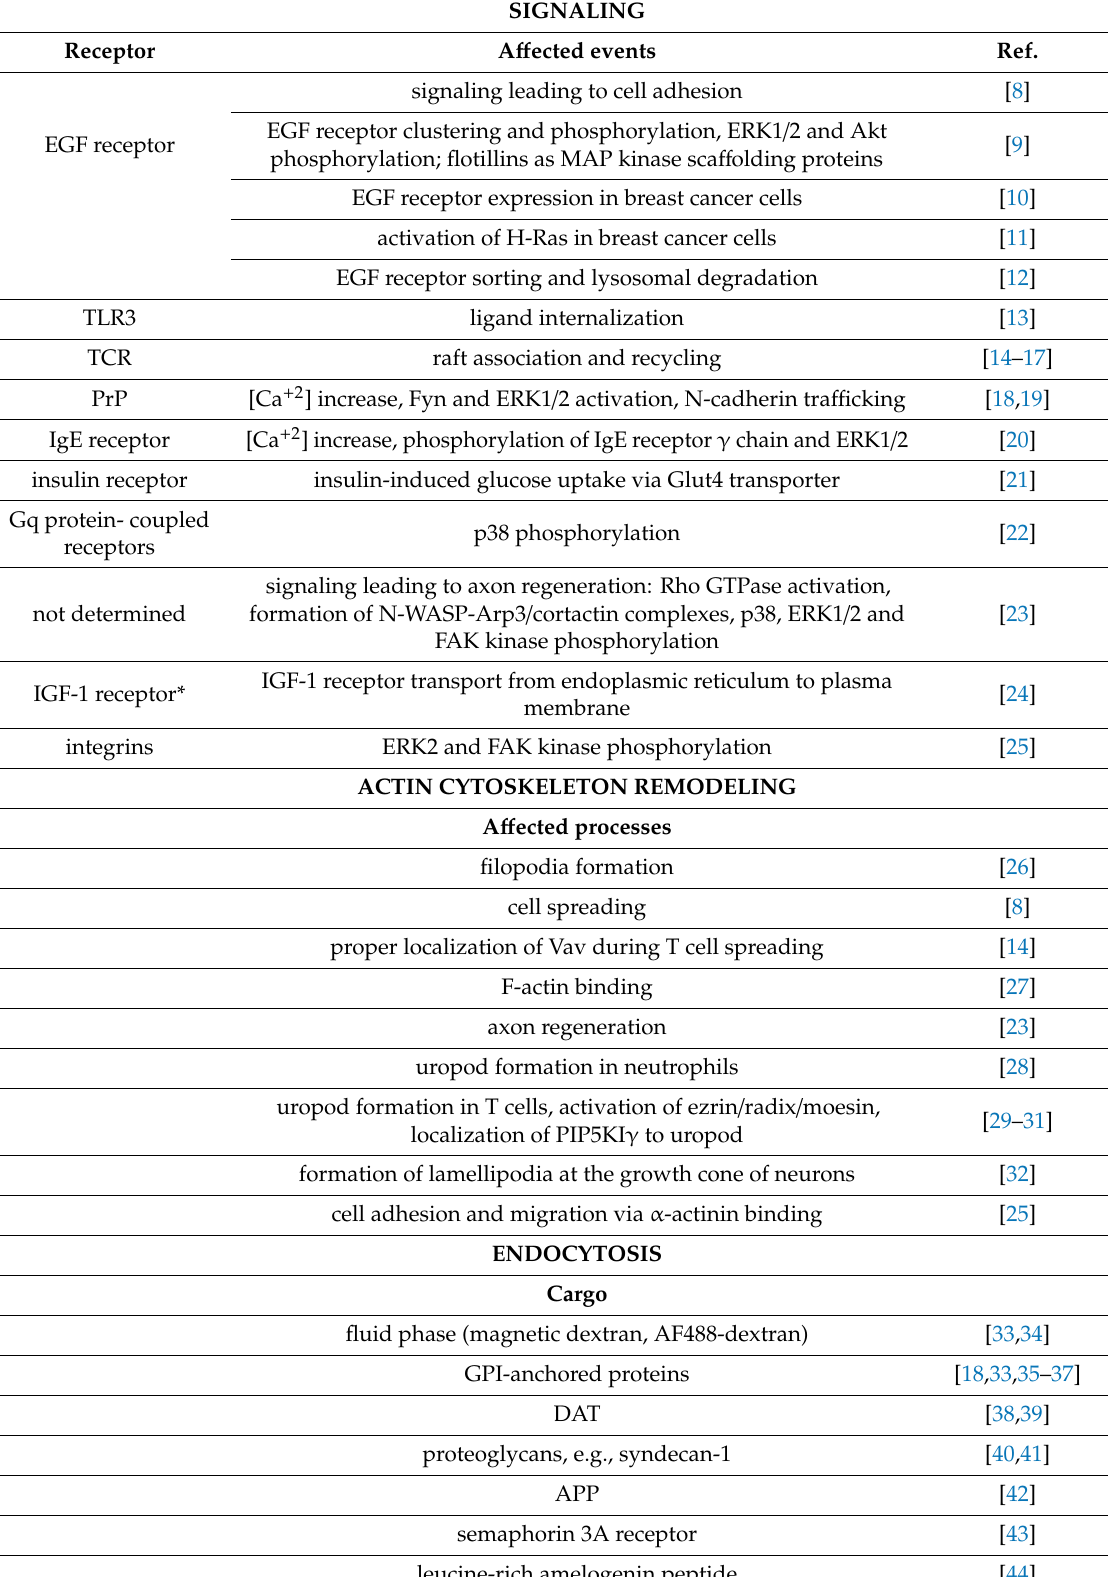
Table 1. Cellular processes involving